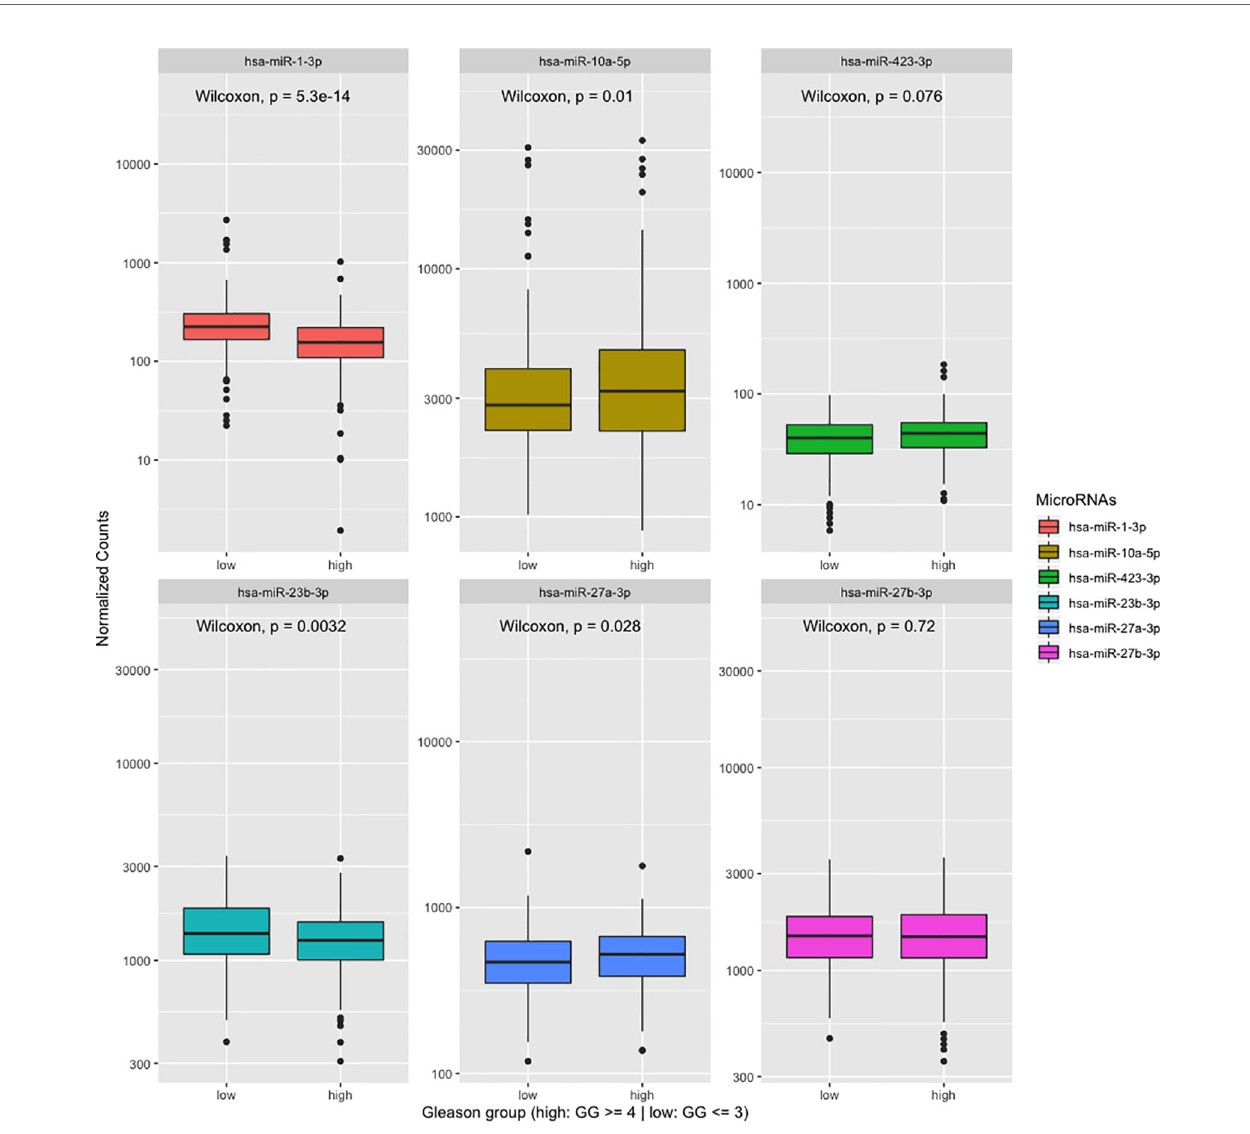
FIGURE 7 | Expression of the differentially expressed microRNAs found in our analysis in the TCGA dataset grouped by Gleason grade 4 (GG4 or greater: high) versus GG3 or lower and Bx-negative (low) n =